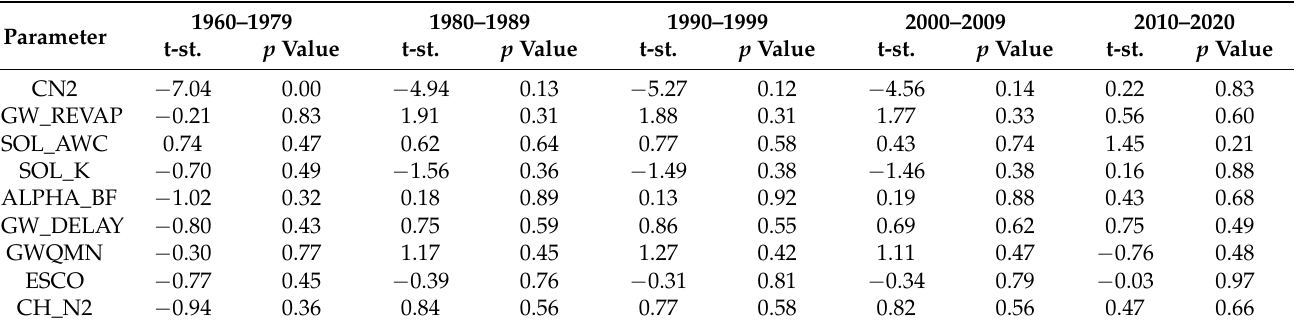
Table 3. Results of parameter sensitivity analysis of the Huangbizhuang Station.